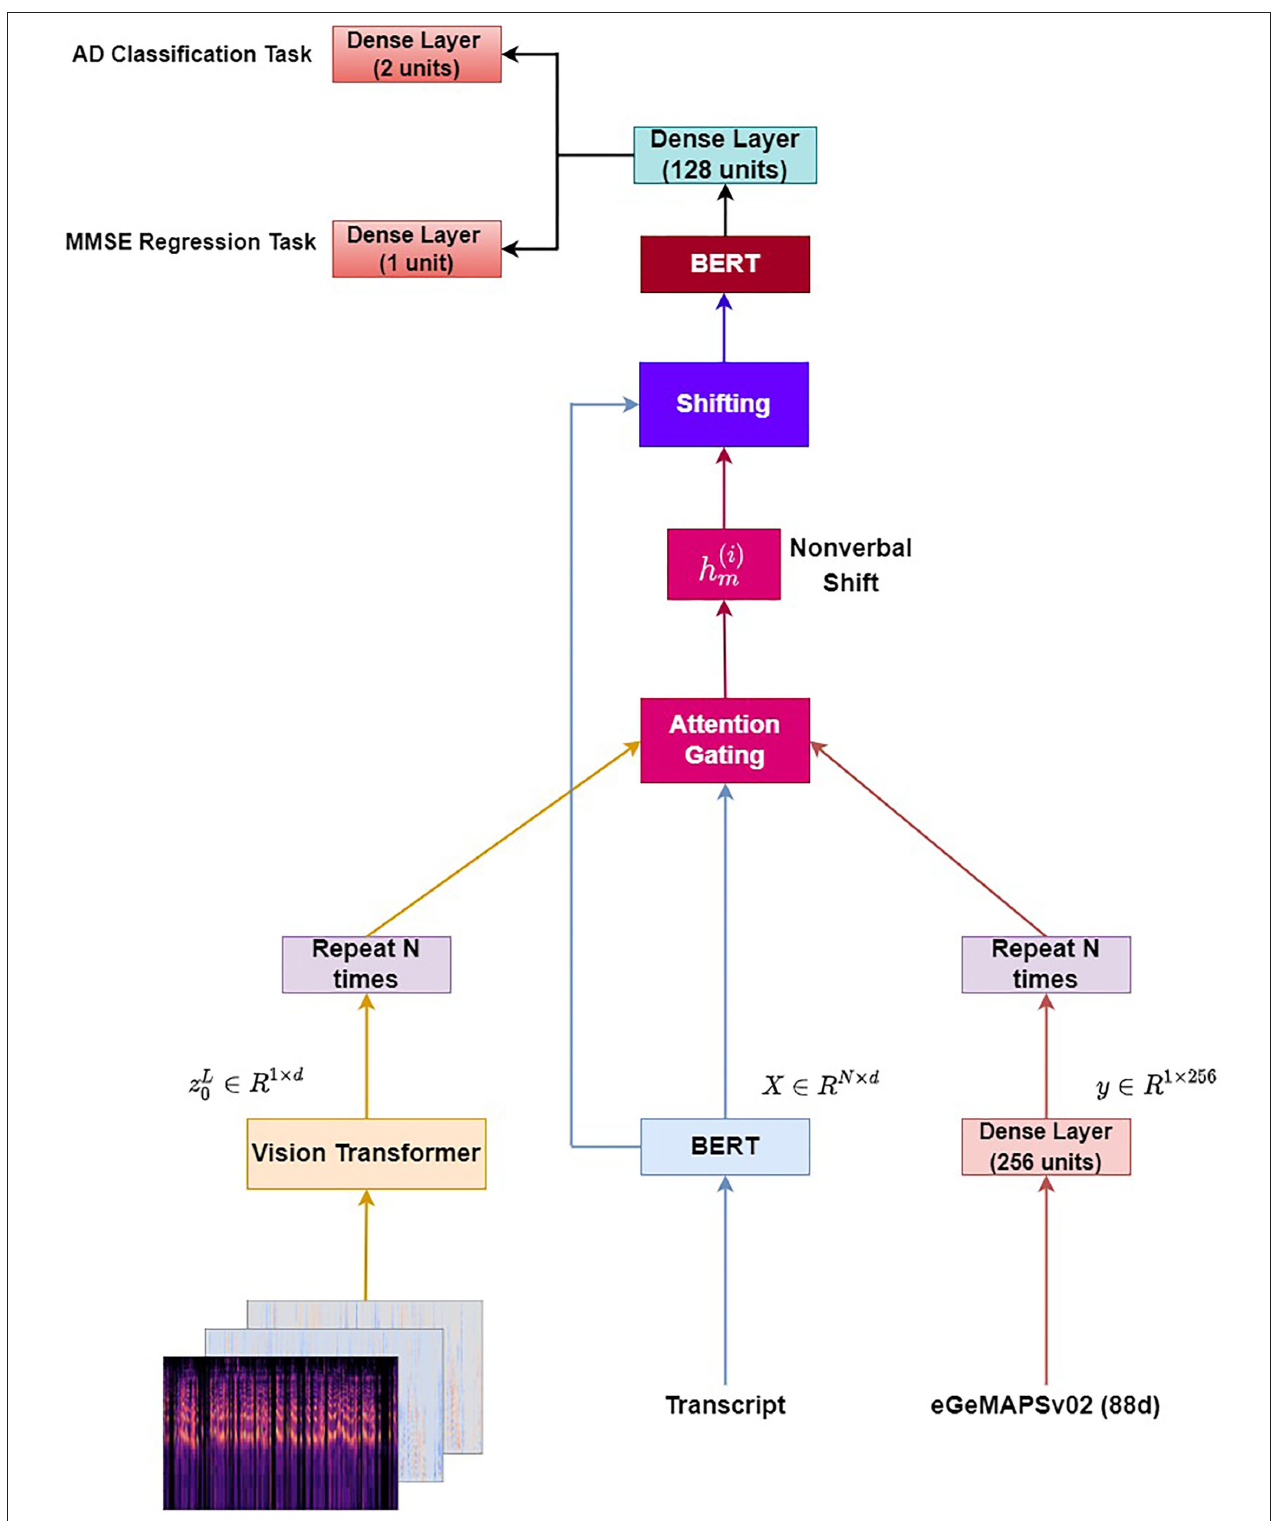
FIGURE 2 | Multimodal BERT - eGeMAPS +